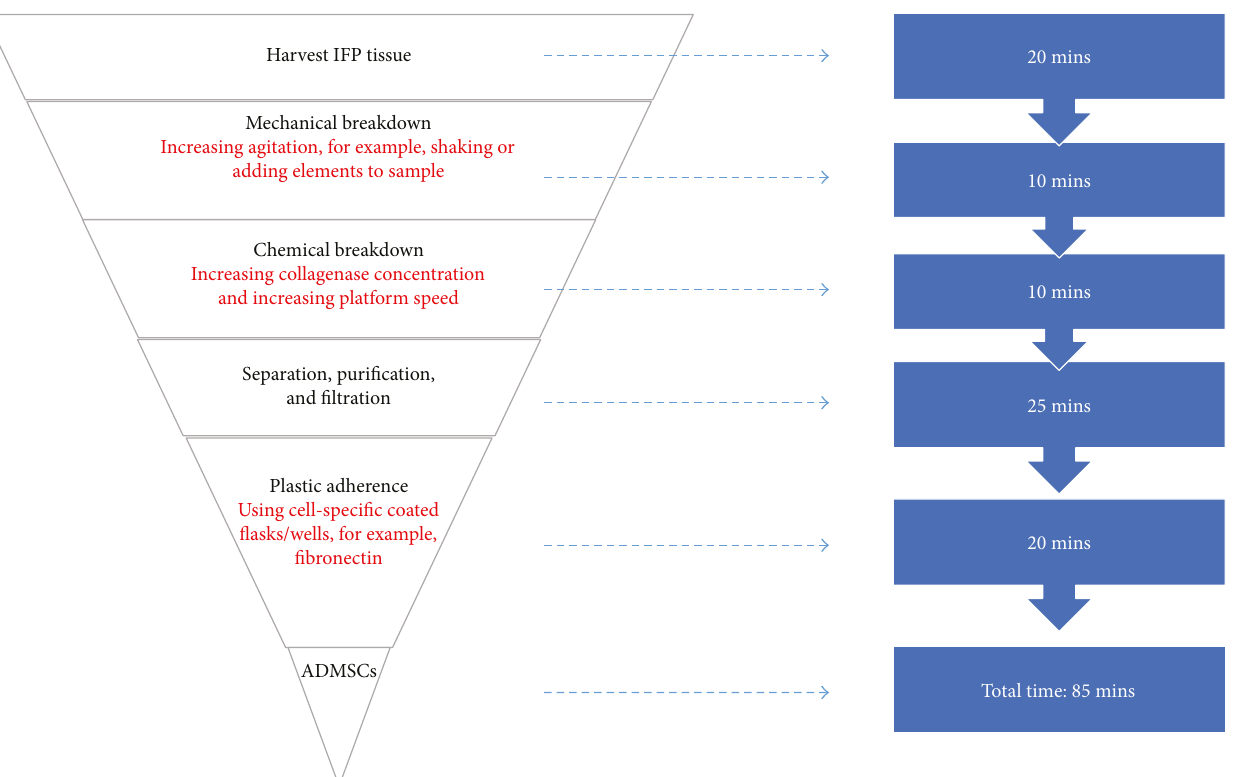
Figure 4: Proposed rapid adipose-derived mesenchymal stem cell (ADMSC) isolation procedure from the infrapatellar fat pad (IFP). The three major changes proposed are highlighted in